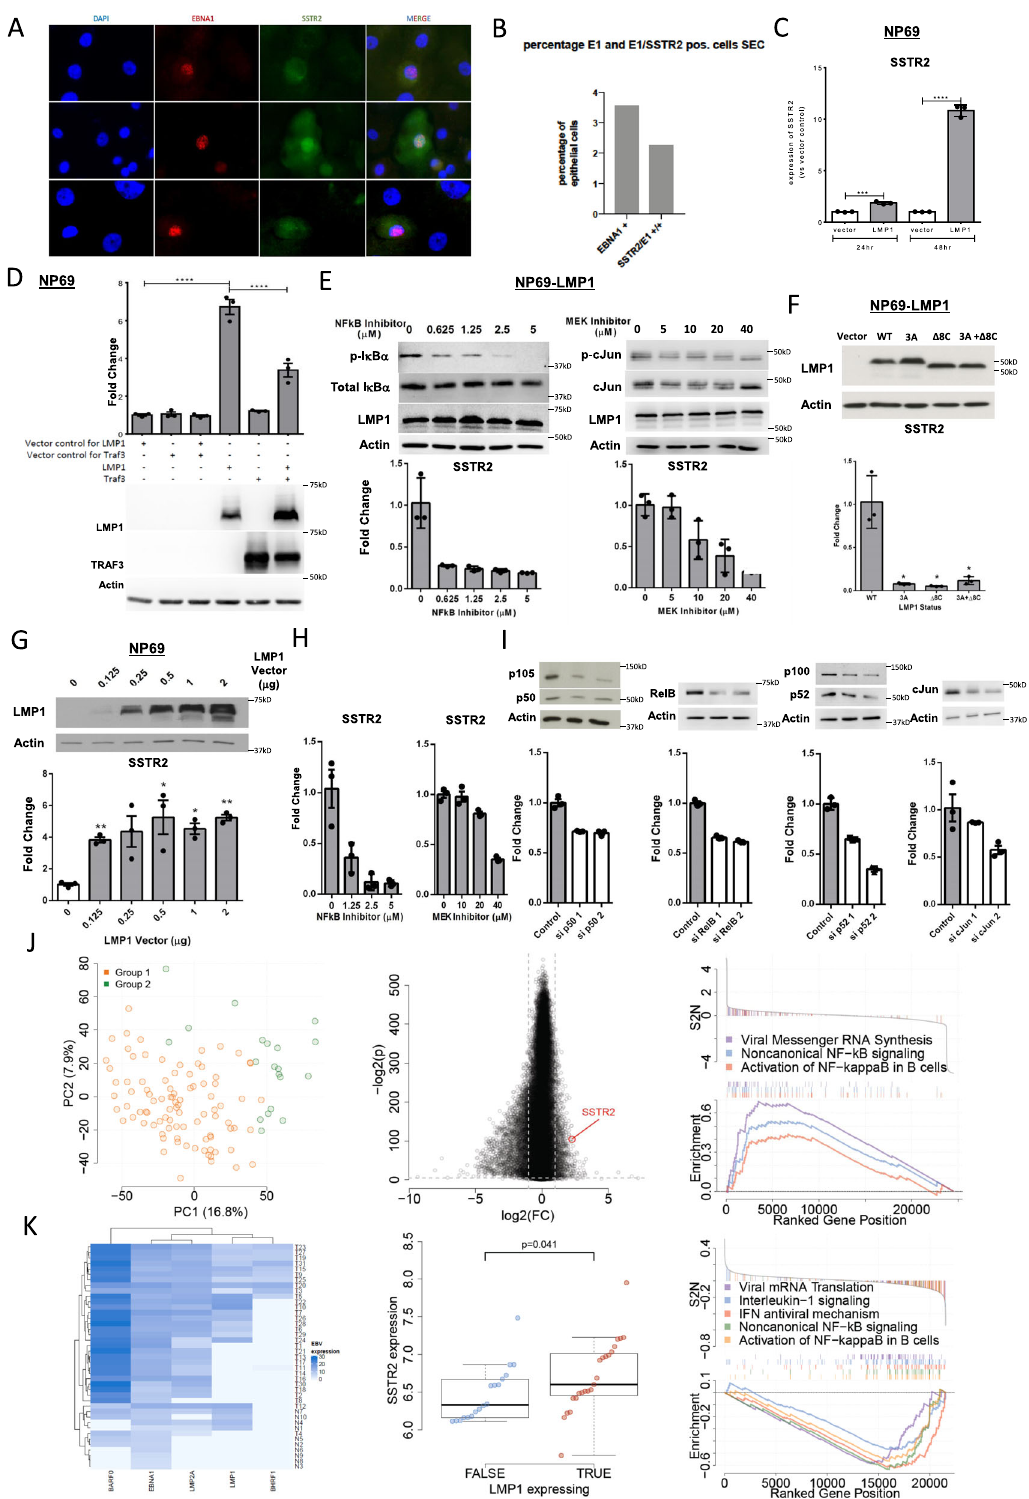
used in the treatment of patients with NPC, and a range of SSTR2 agonists, including the FDA-approved lanreotide and octreotide and PEN-221, which is in Phase 1/2a clinical trial in the UK and US for NET patients 21 . PEN-221 is a drug conjugate made up of a peptide that is highly selective for SSTR2 conjugated to the tubulin polymerization inhibitor DM1 and has shown effective- ness in preclinical models 22 . Unlike in NETs, lanreotide